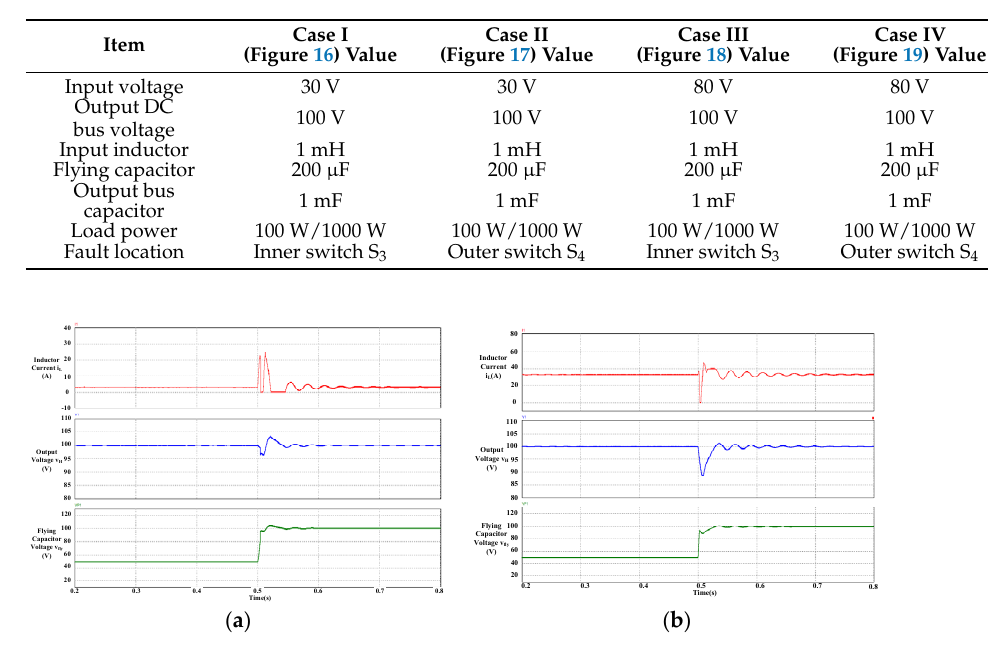
Figure 16. The waveforms of S 4 short-circuit fault (V L < 0.5 V H ). ( a ) Light load 100 W; ( b ) heavy load 1000 W.